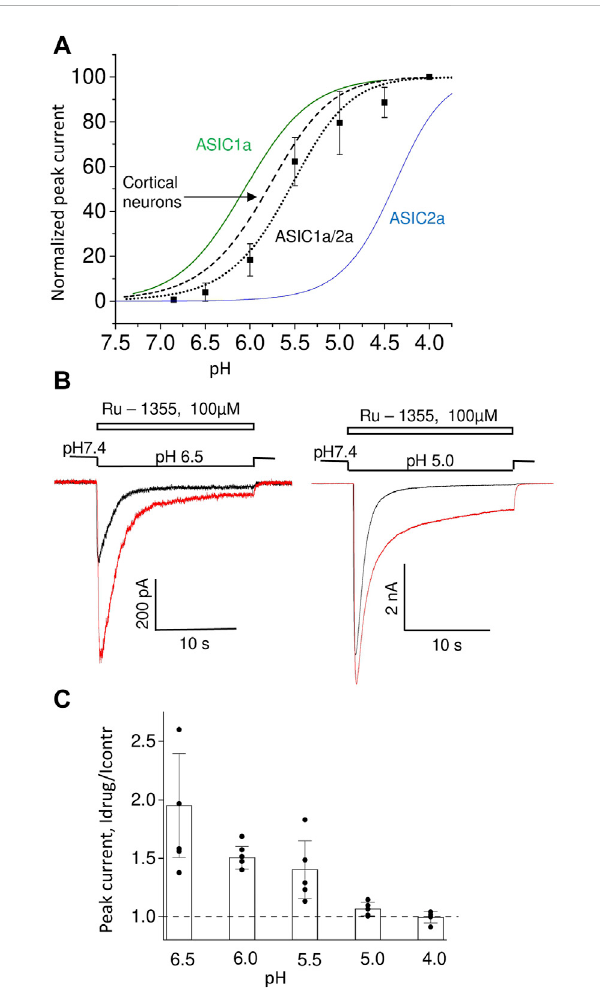
FIGURE 7 Action of Ru-1355 on ASIC1a/ASIC2a. (A) , pH dependence of peak current amplitudes. For comparison, the pH dependencies for homomeric ASIC1a and ASIC2a are presented. The data on native ASICs in cortical pyramidal neurons are taken from (Tikhonova and Barygin, 2019). ASIC1a data are from Nikolaev et al. (2019). ASIC2a data are from Figure 5C of the present work. (B) , representative responses at pH 6.5 (left) and pH 5.0 (right) in control (black) and in the presence of 100 μ M Ru-1355 (red). The peak component is strongly potentiated at pH6.5butnotatpH5.0.Thesustainedcomponentispotentiatedinboth cases. (C) , pH dependence of Ru-1355